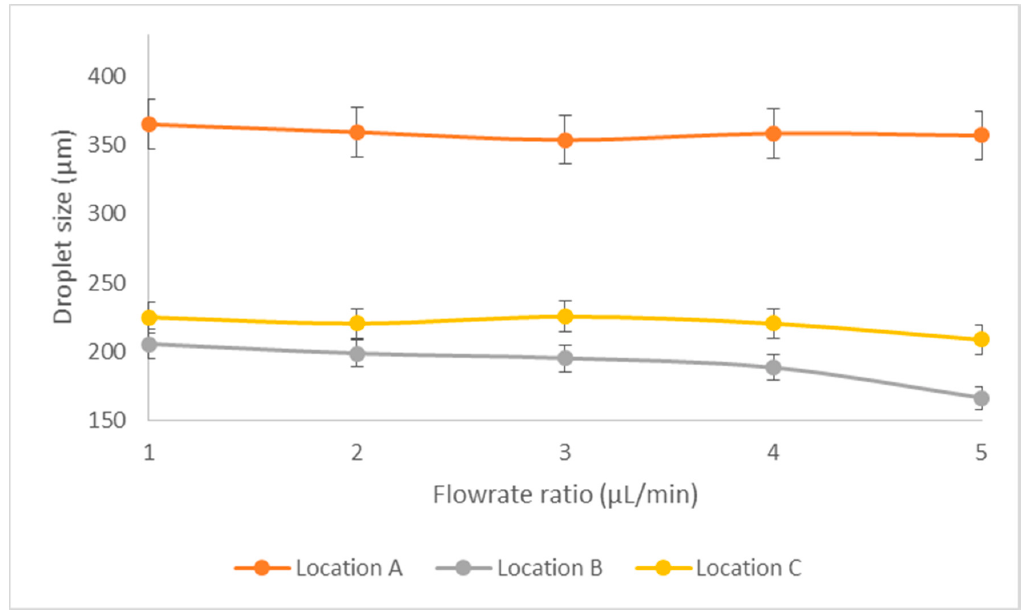
Figure 12. Droplet fission droplet profiles at different flow ratios. x -axis denotes the flowrate ratio pair of continuous and dispersed phase flowrate ranging from 2:6 to 6:18 μ L/min.